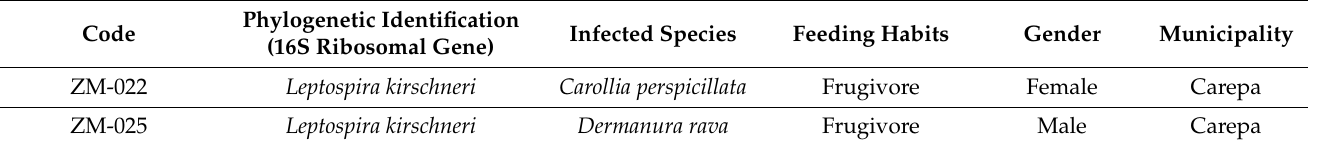
Figure 3. Molecular detection of bats naturally infected with Leptospira . The figure shows a 1% agarose gel with the amplification products of 20 bats infected with Leptospira spp. The band (331 base pair) corresponding to a fragment of the 16S ribosomal gene. A 100 base pair molecular weight markers were used. Additionally, a positive control (C+: Leptospira interrogans ) and a negative control (C-: PCR reagents without DNA) were used in all reactions. Table 2. Natural infection of bats with different Leptospira species. This table shows the code of the positive samples, Leptospira species identified by amplification of the 16S ribosomal gene, bat species infected, and the municipality from which the sampling area